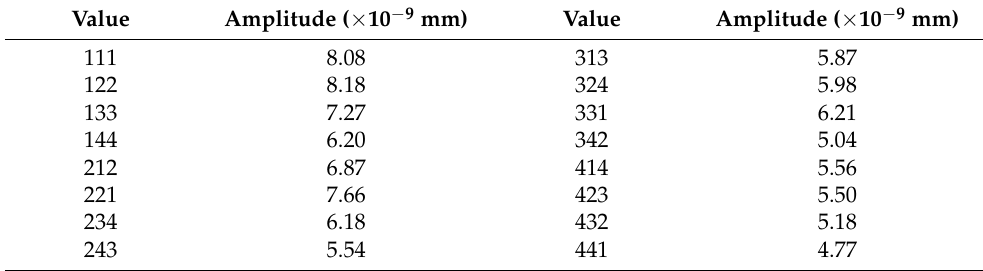
Table 3. Received signal amplitude of different value